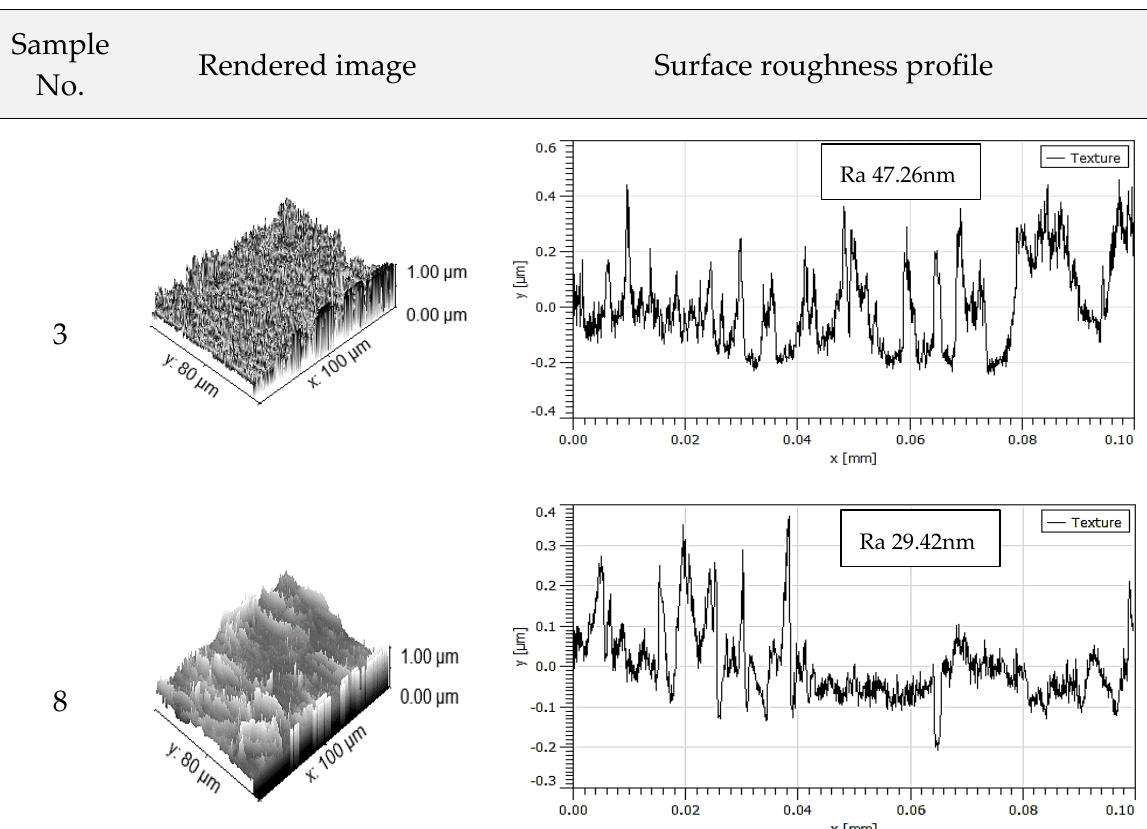
Figure 11. Surface Roughness analysis using Gwydion open software tool.